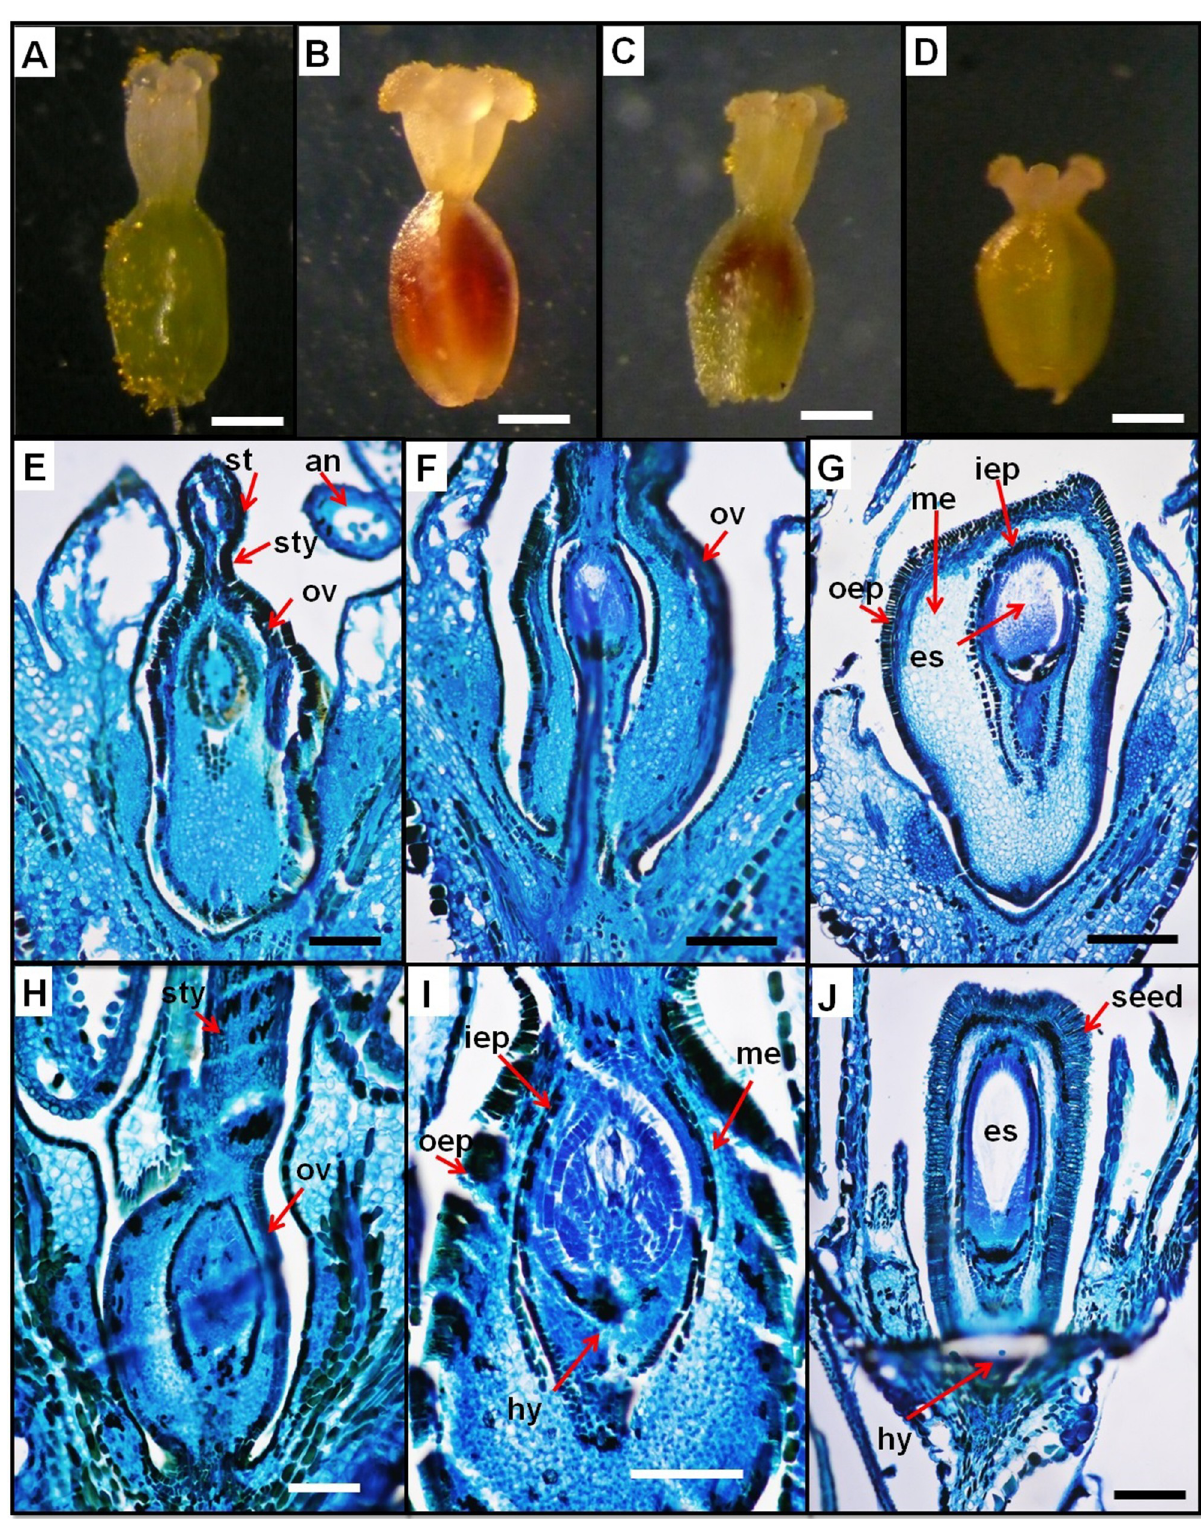
Fig 4. Anatomical aspects of the ovary. P . equisetiforme var. graecum (A), P . equisetiforme var. peyerinhoffi (B), P . aviculare (C), and P . maritimum (D) under stereomicroscope. Longitudinal section of the flower and young fruit in P . maritimum (E, F and G) and P . equisetiforme (H, I and J). Abbreviations: hy, hypostase; iep, inner epidermis; oep, outer epidermis; me, mesophyll, ov, ovary; sty, style; st, stigma; es, embryo sac. Scale bars: A, B, C and D = 800 μ m; E, F, G, H, and J = 400 μ m; I = 300 μ